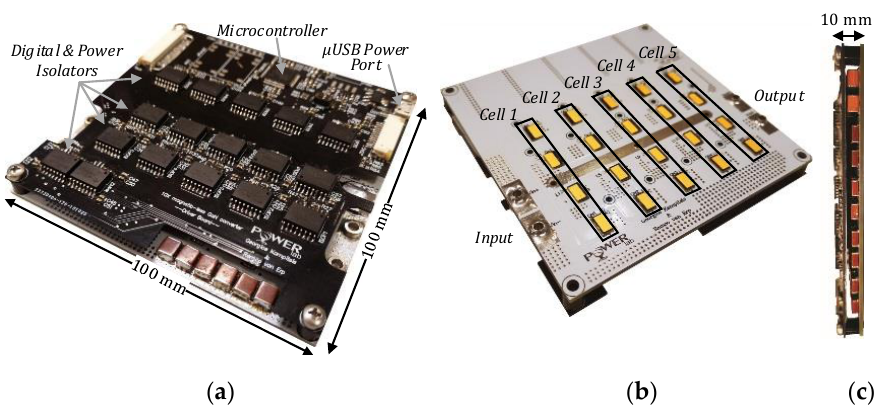
Figure 10. ( a ) Front side — drive board, ( b ) back side — power board and ( c ) side view of the magnetic-free nX converter prototype.